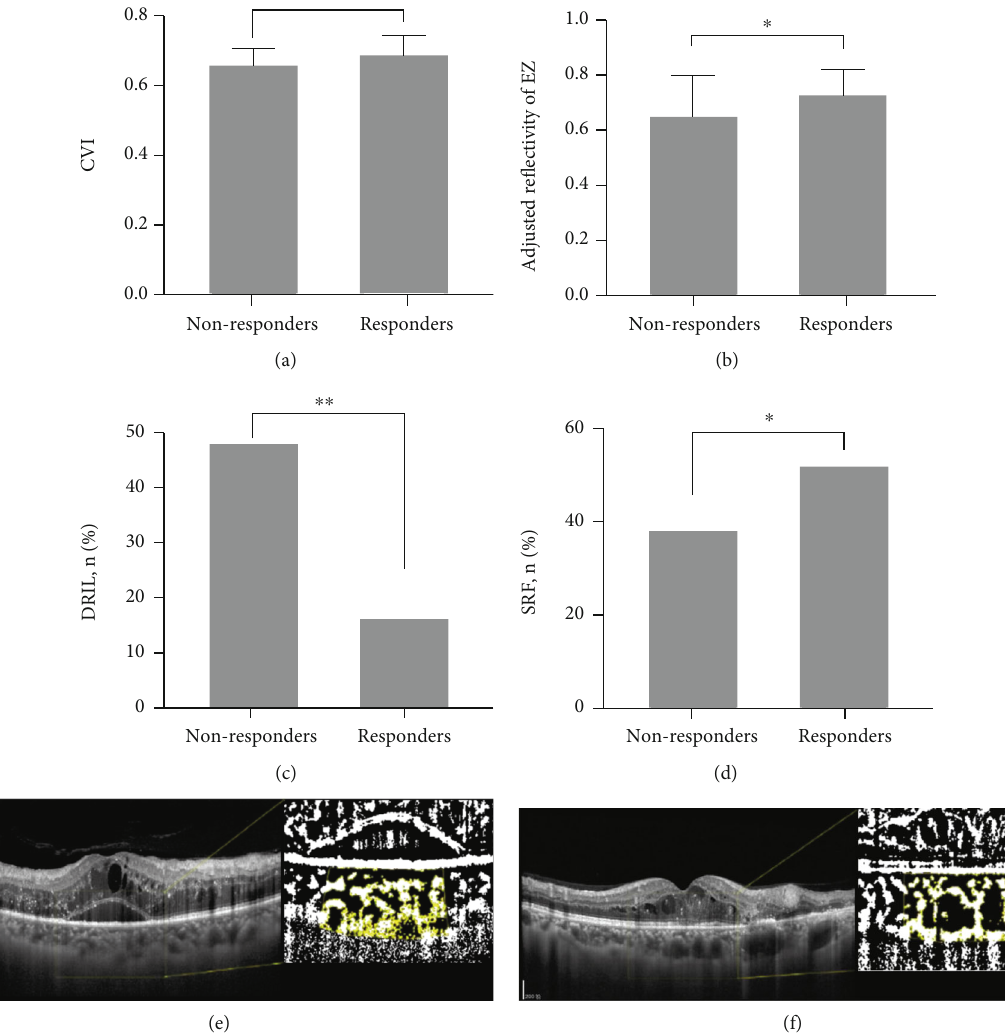
Figure 2: Baseline optical coherence tomography (OCT) morphological features between responders and nonresponders. Baseline choroidal vascularity index (CVI) (a). Adjusted ellipsoid zone (EZ) re fl ectivity (b). Proportion of disorganization of the retinal inner layers (DRIL) (c). Subretinal fl uid (SRF) (d) in responders and nonresponders. The left eye of a 50-year-old man had a baseline CVI of 62%. Her baseline BCVA was 20/100. After three injections of VEGF inhibitors, the visual acuity decreased to 20/160. The treated eyes were categorized as nonresponders (e). The right eye of a 44-year-old man had a baseline CVI of 69%. Her baseline BCVA was 20/63. After three injections of VEGF inhibitors, the visual intensity increased to 20/40. The treated eyes were categorized as responders